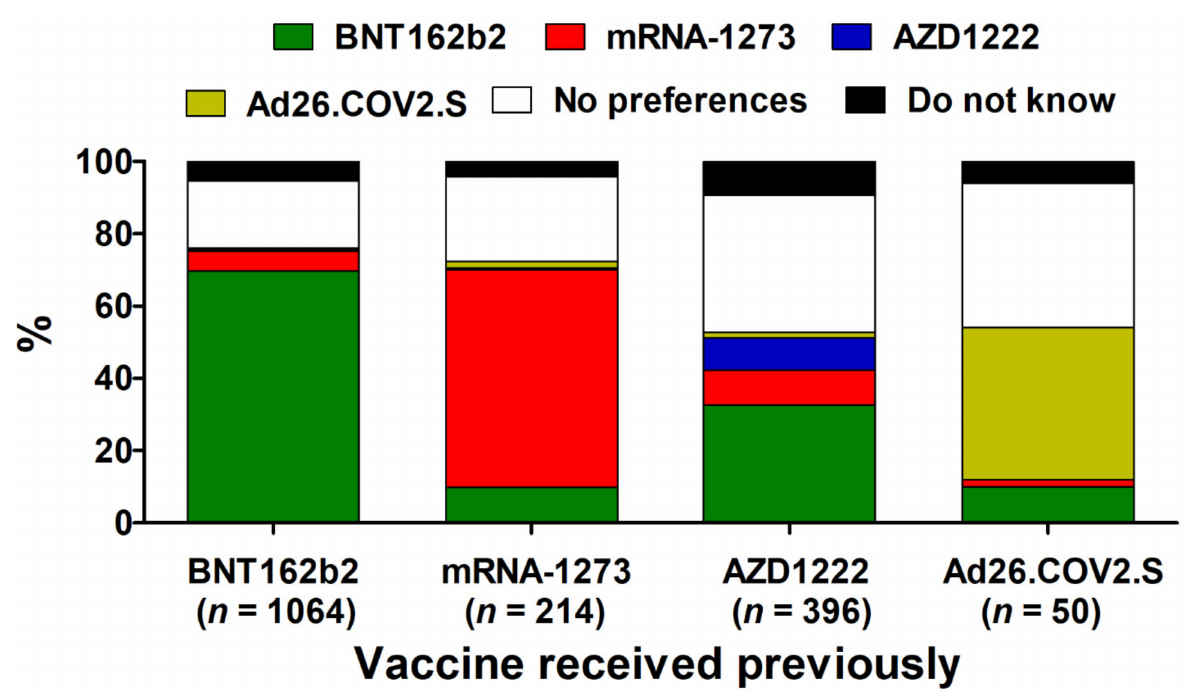
Figure 4. The preference of the specific COVID-19 vaccine to be used as the potential booster dose in the groups previously vaccinated with BNT162b, mRNA-1273, AZD1222, and Ad26.COV2.S ( n =